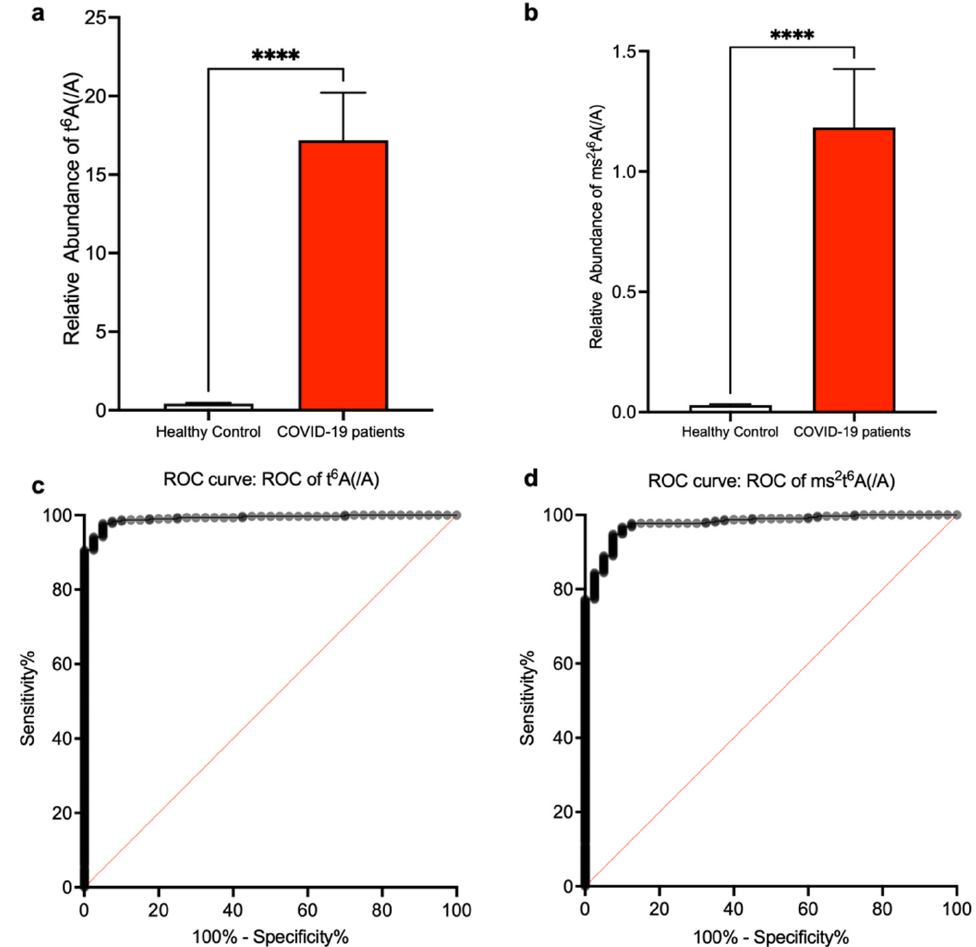
Figure 4. Elevation of t 6 A and ms 2 t 6 A in serum of COVID-19 patients. ( a , b ) Measurements of t 6 A ( a ) and ms 2 t 6 A ( b ) in serum of COVID-19 patients and comparison with healthy volunteers. LC-MS peak areas of t 6 A or ms 2 t 6 A divided by LC-MS peak areas of adenosine are shown. **** p < 0.0001 by Mann–Whitney U test. ( c , d ) ROC analysis for t 6 A ( c ) and ms 2 t 6 A ( d ) levels in serum was performed for calculation of sensitivity and specificity.